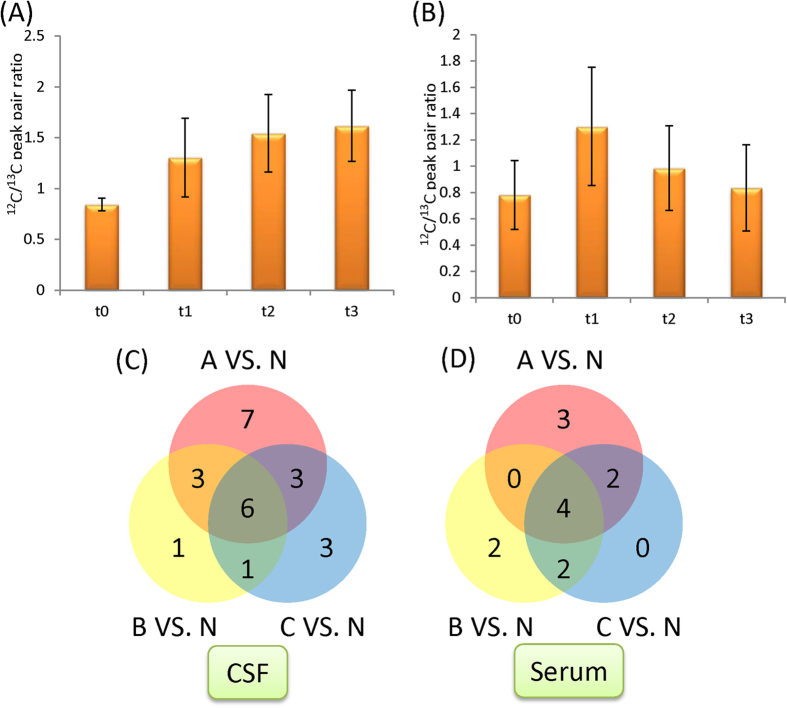
Examples showing how metabolite change with time.(A) Pattern 1: gradual increase or decrease over time; (B) pattern 2: an abrupt change at t1 followed by gradual restoring of the metabolite level. Venn diagram showing the number of metabolites that are significantly different (fold change >1.5, p < 0.05) between injured and non-injured samples in (C) CSF and (D) serum. A: AIS A; B: AIS B; C: AIS C; N: non-injured control.